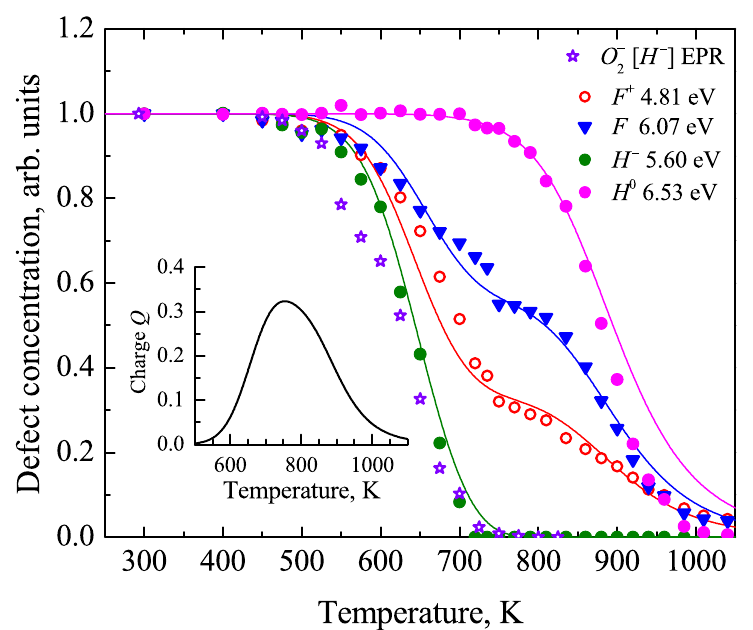
Figure 5. The normalized experimental annealing kinetics for four types of primary defects (stars for EPR, other symbols for optics)) and their theoretical analysis (full lines). Insert shows the electronic charge released due to recombination of F + – H 0 and F – H − pairs. The values of OD at I max were taken to follow the annealing of the corresponding defects via optical absorption. H − arise via the thermal decay of paramagnetic O 2 −